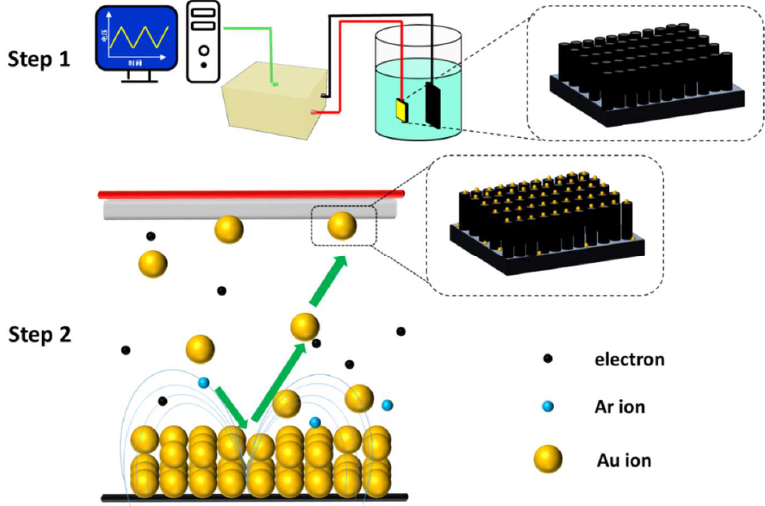
Figure 1. Schematic diagrams of the process to construct Au@TNTs.